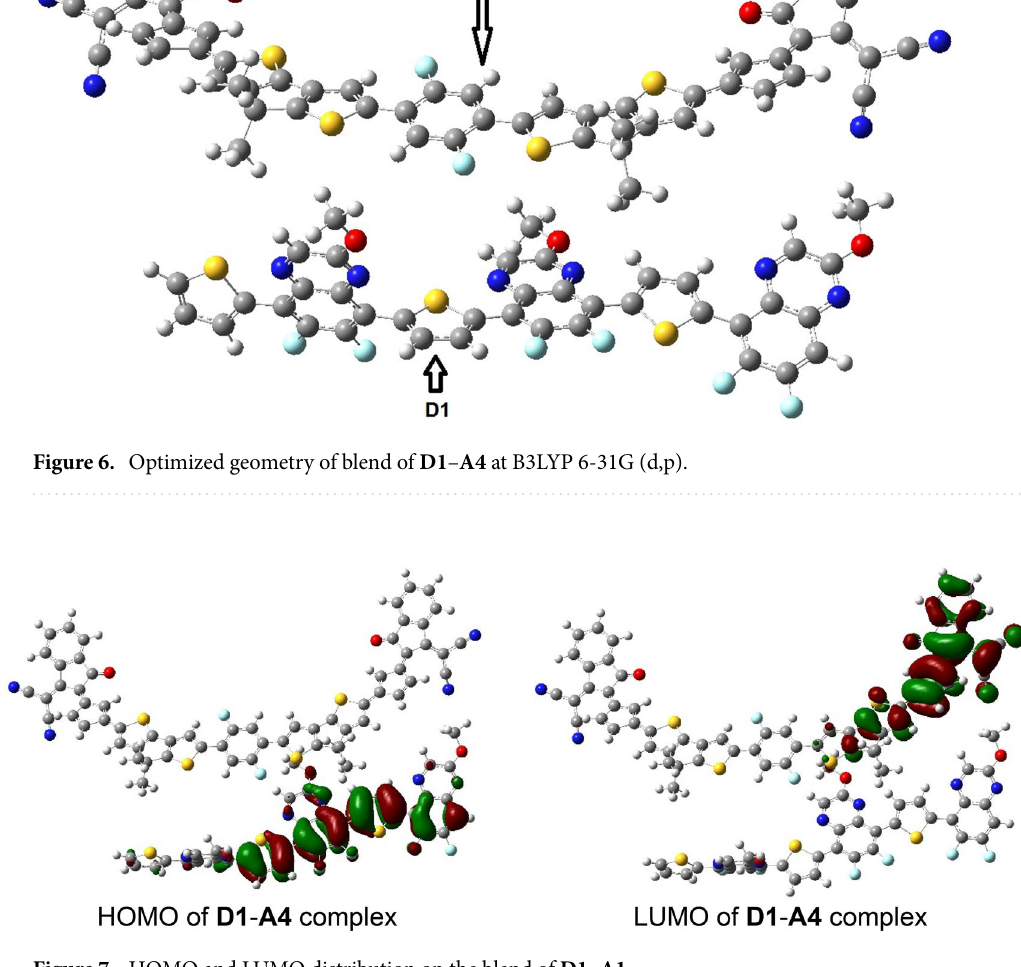
Figure 7. HOMO and LUMO distribution on the blend of D1 –